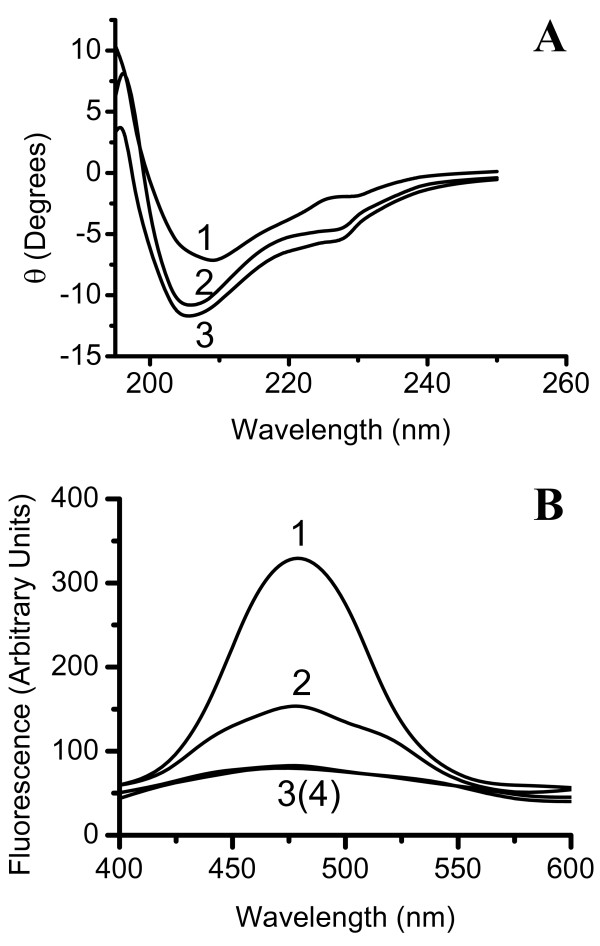
Conformational changes of polymerized tau in formaldehyde solution. (A) Circular dichroism spectra of 2 μM native tau (curve 2), and tau incubated with 0.1% formaldehyde (curve 1) or acetaldehyde (curve 3) at 37°C for 24 h. Scattering contributions of the aldehyde were subtracted from the spectra. (B) Changes in the fluorescence of tau in the presence of ANS. Tau (1.2 μM final concentration) was incubated in 100 mM phosphate buffer (pH 7.2) with or without 0.1 % aldehyde at 37°C overnight and then ANS (molar ratio: tau/ANS = 1/40) was added. Changes in the ANS fluorescence spectra at 480 nm for tau incubated with formaldehyde (curve 1), acetaldehyde (curve 3) or without aldehyde (self-aggregation, curve 2) were measured by excitation at 350 nm. Formaldehyde alone (curve 4) is shown as a control.